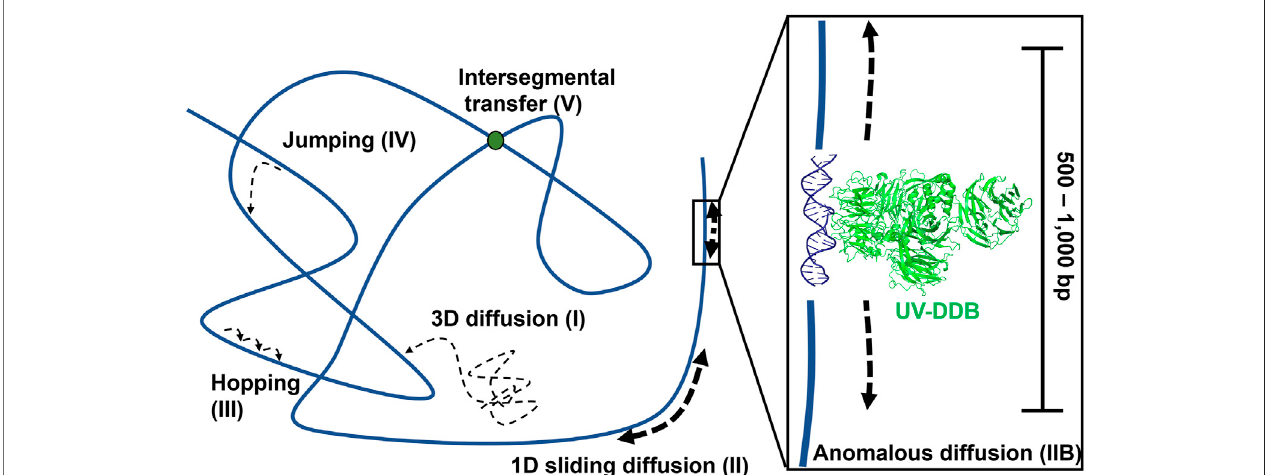
FIGURE4| Modesofprotein-DNA interaction. Types ofprotein motionshown include3Ddiffusion(I),1Dlineardiffusion/sliding(II),anomalous diffusion(IIB) asub- diffusive movement along restricted regions of the DNA, hopping (III), jumping (IV), and intersegmental transfer (V). On the right side of the panel, a close-up view of anomalousdiffusionisshown,inwhichaprotein suchasUV-DDB, inthepresenceofMg 2+ ,slides backand forthalong500 – 1,000 bpofDNA.PDBID: 4E5Z(Yehet al., 2012). DNA repair proteins probably use a combination of all search strategies to ef fi ciently detect DNA